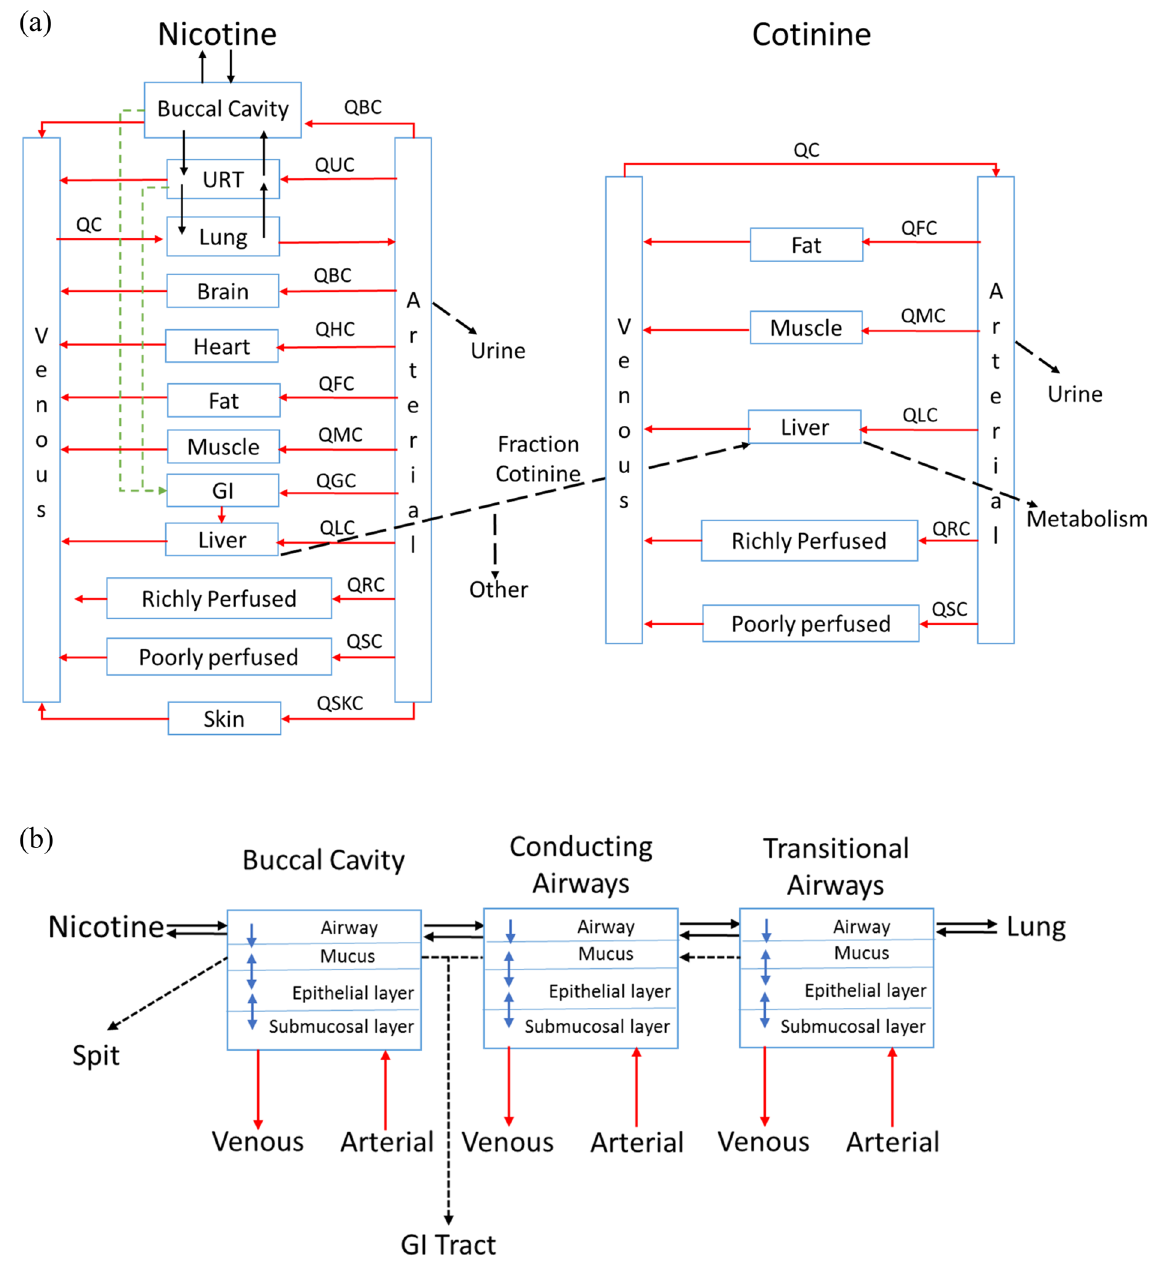
Figure 10. Nicotine PBPK model structure including all compartments included, with three separate administrations routes: ( a ) physiological model, ( b ) respiratory tract